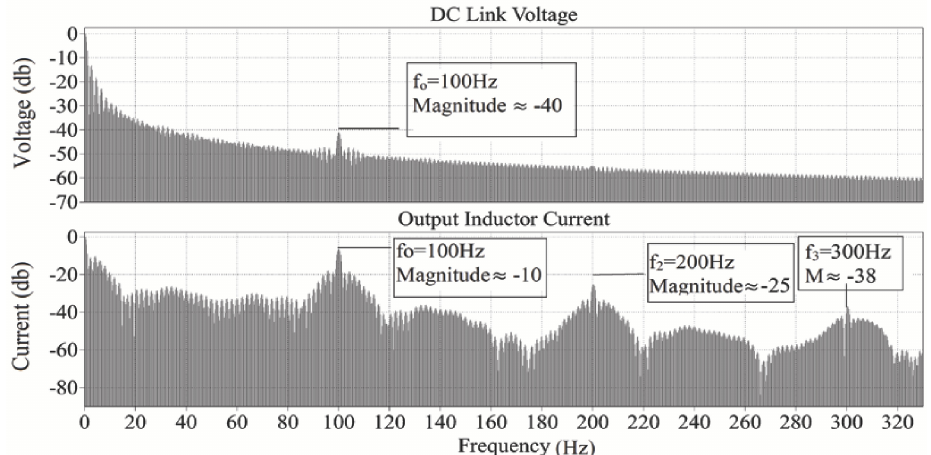
Figure 12. Frequency domain simulation of the converter depicting the output voltage V o and output inductor current i o low frequency components.